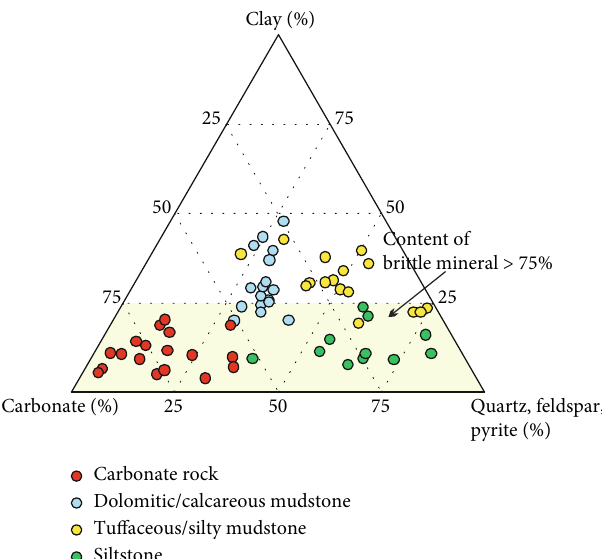
Figure 12: Ternary diagram showing the mineralogy of the di ff erent lithofacies in the Lucaogou Formation, Jimusar